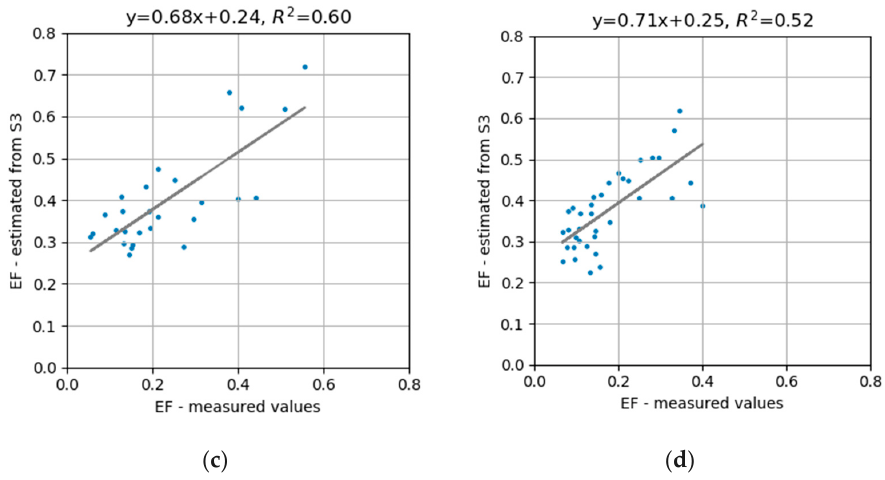
Figure 6. Comparisons of EF: ( a ) for all sites in Spain, ( b ) for the ES-Abr site only, ( c ) for the ES_ELM1 site only, and ( d ) for the ES-LM2 experimental site only. Table 3. Summary of the EF comparisons.